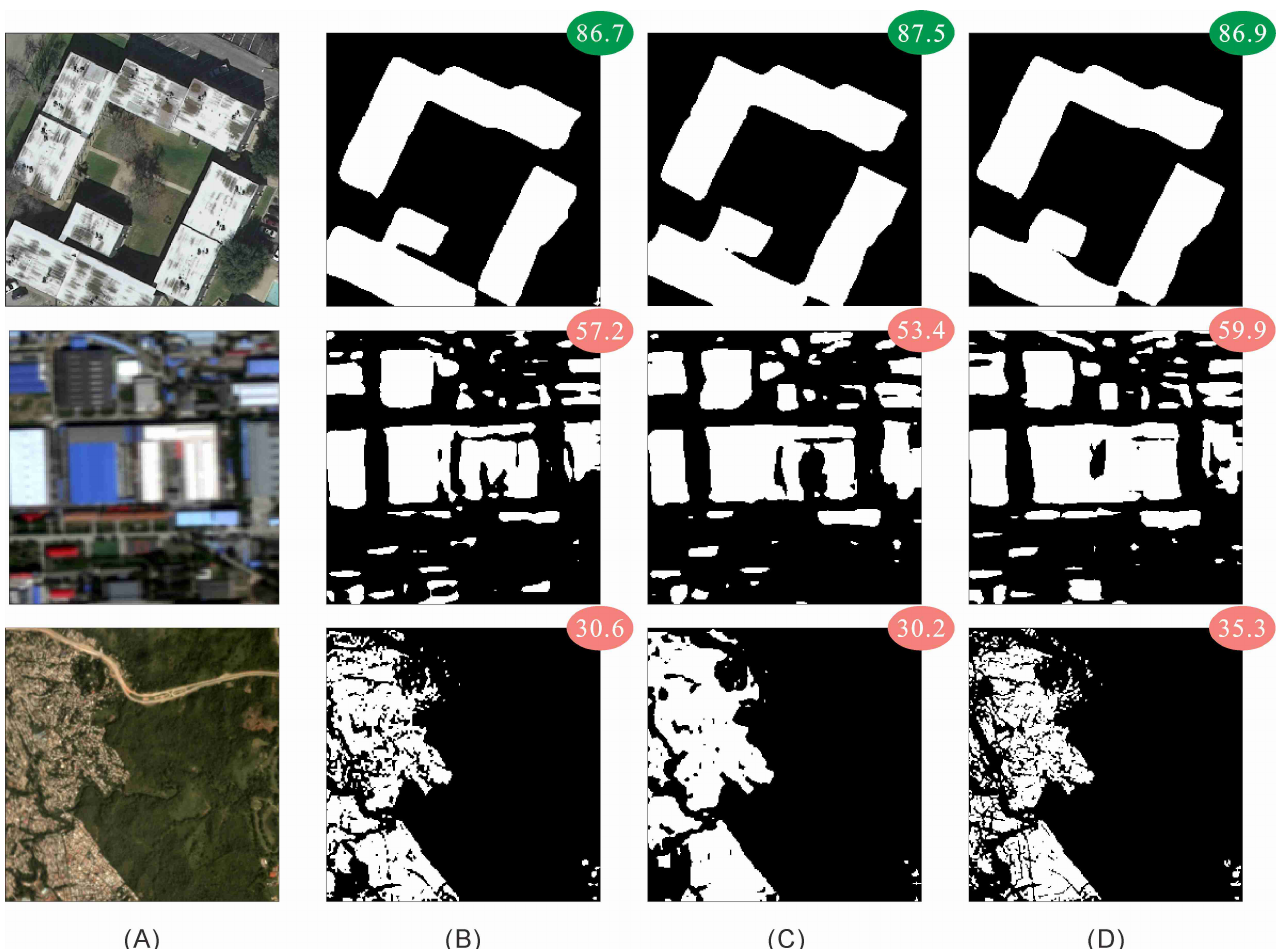
Figure 2. Real-world examples of the SOTA method. From top to bottom, the resolution of the images are 0.3, 4, and 8 m/pixel, respectively. The circle in the upper right of the images indicates the Intersect Over Union (IoU) score (%) for buildings. ( A ) Image. ( B ) Unet++. ( C ) EPUNet. ( D )